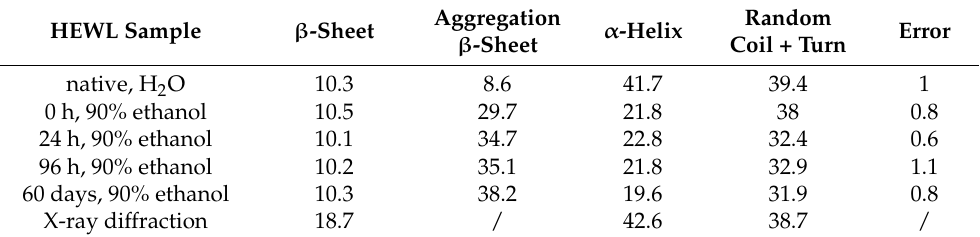
Aggregation Random α -Helix Error β -Sheet Coil + Turn